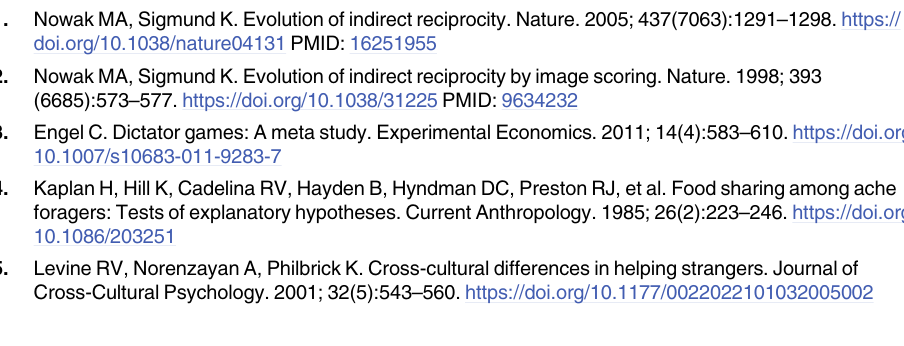
S2 Table. Effect of another participant’s empathy on expected prosocial behavior, type matching—Pooled OLS regression. S3 Table. Effect of the recipient’s empathy on prosocial behavior, type matching—Pooled OLS regression. S4 Table. Effect of differences between the own amount sent and the expected amount sent of the counterpart on prosocial